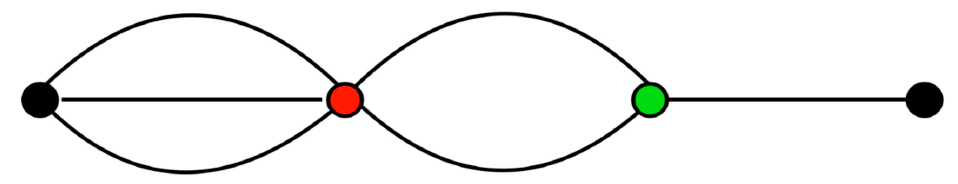
circle), 𝑴 (cid:3037) (green circle) and 𝑹 (cid:3037)(cid:3036) (black circle). circle), M j (green circle) and R ji (black